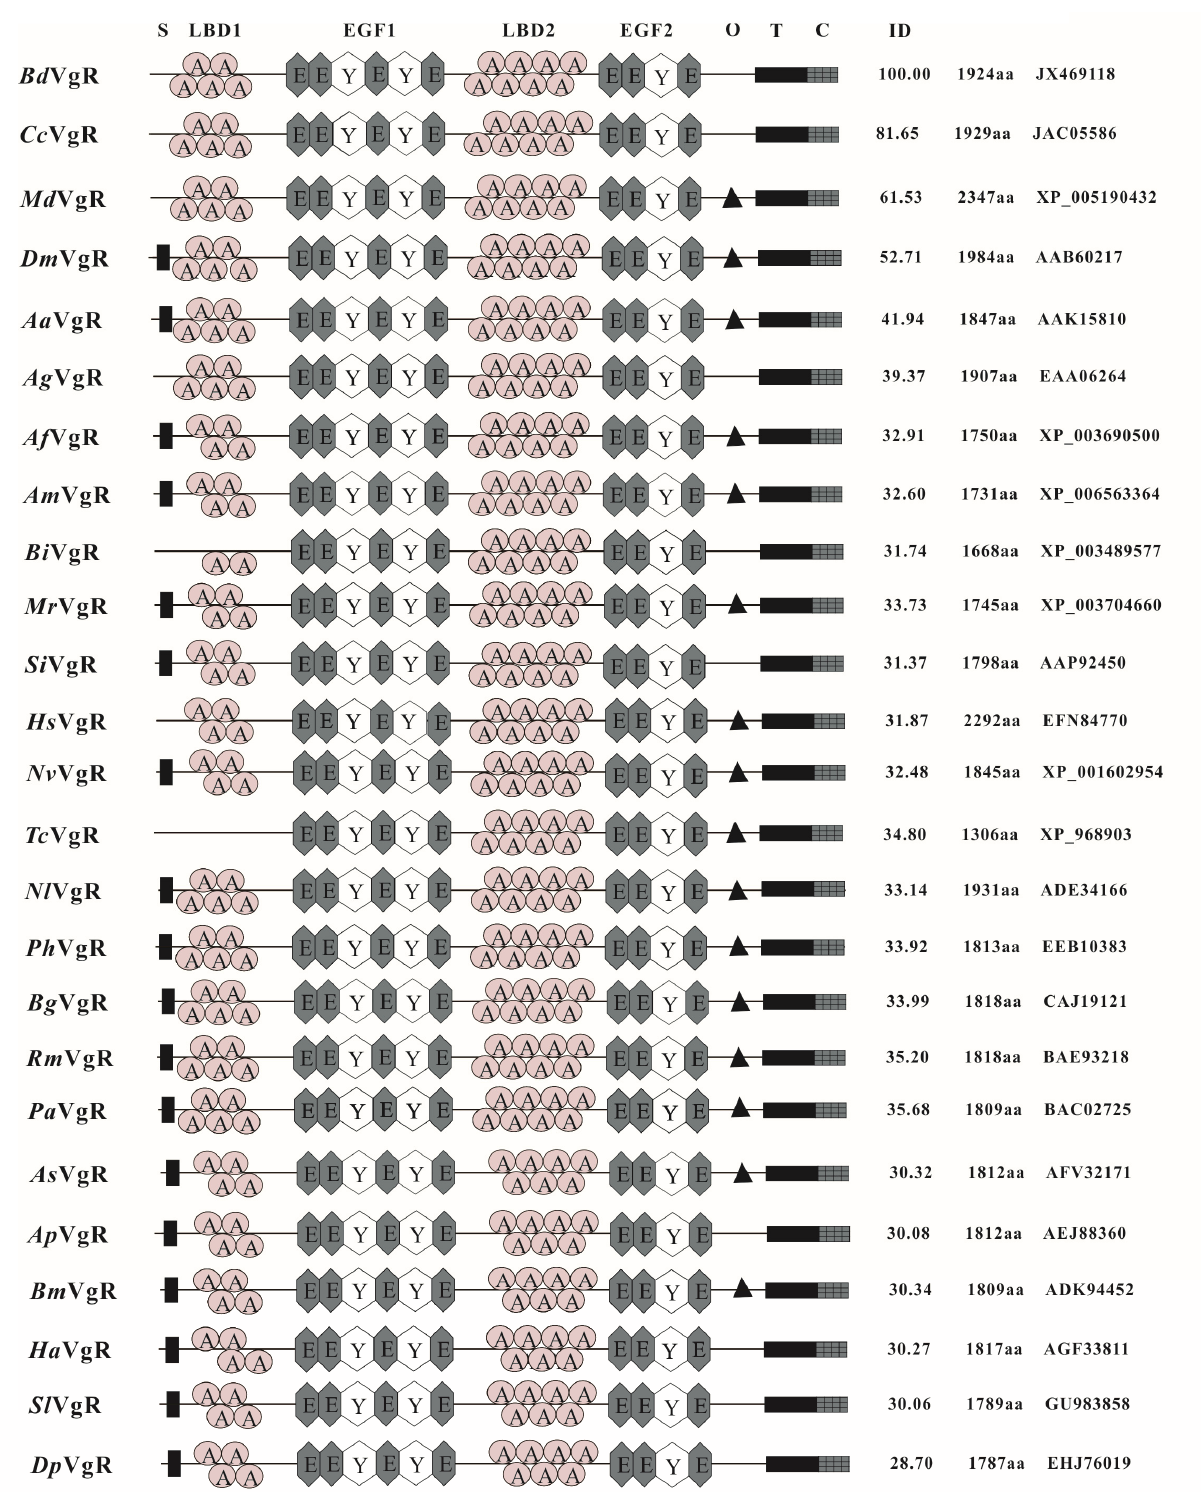
Figure 1. Diagrammatic comparison of typical domains of B. dorsalis vitellogenin receptor with other insect vitellogenin receptor. S, signal peptide; LBD, ligand binding domain; EGF, EGF-precursor domain; O, O-linked sugar domain; T, transmembrane domain; C, cytoplasmic domain; ID, identity; A, LDLR A ; E, EGF-like repeat; Y, YWTD; Bd VgR, Bactrocera dorsalis , JX469118; Cc VgR, Ceratitis captitata , JAC05586; Md VgR, Musca domestica , XP_005190432; Dm VgR, Drosophila melanogaster , AAB60217; Aa